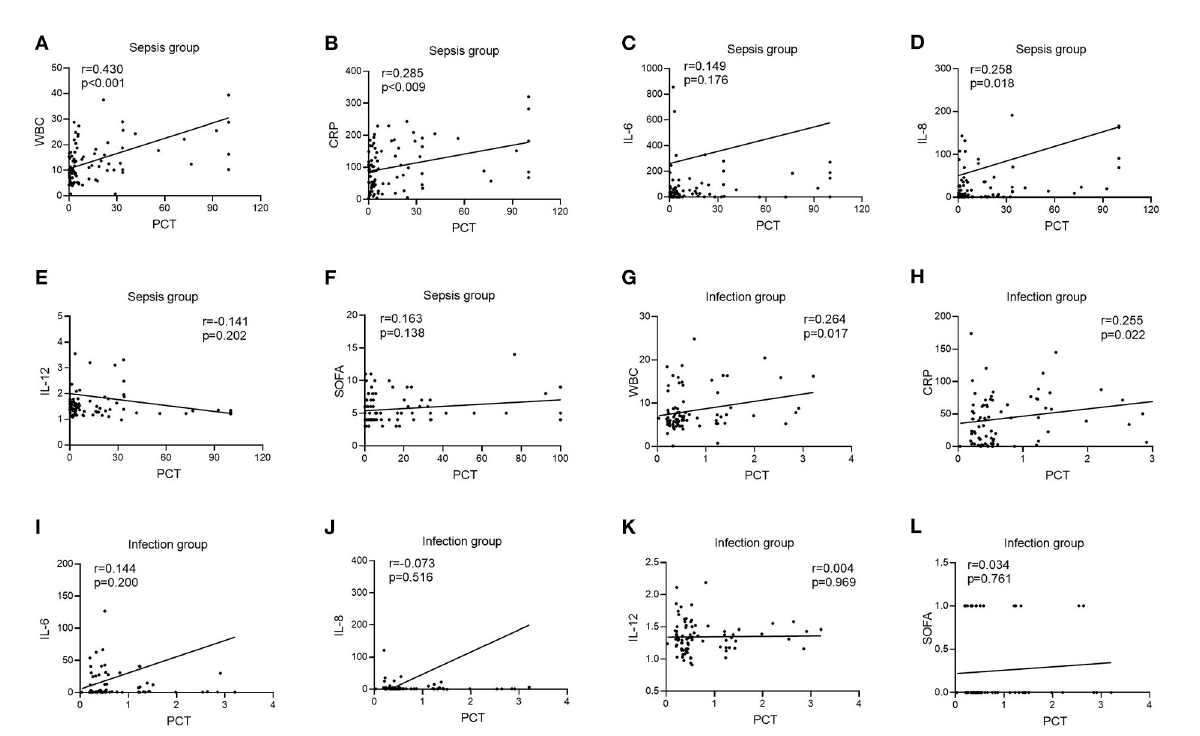
FIGURE5 Correlation of PCT with WBC, CRP, IL-6, IL-8, IL-12, and SOFA scores in patients in the infection and sepsis groups. (A) Correlation of PCT with WBC in patients in the sepsis groups; (B) Correlation of PCT with CRP in patients in the sepsis groups; (C) Correlation of PCT with IL-6 in patients in the sepsis groups; (D) Correlation of PCT with IL-8 in patients in the sepsis groups; (E) Correlation of PCT with IL-12 in patients in the sepsis groups; (F) Correlation of PCT with SOFA scores in patients in the sepsis groups; (G) Correlation of PCT with WBC in patients in the infection groups; (H) Correlation of PCT with CRP in patients in the infection groups; (I) Correlation of PCT with IL-6 in patients in the infection groups; (J) Correlation of PCT with IL-8 in patients in the infection groups; (K) Correlation of PCT with IL-12 in patients in the infection groups; (L) Correlation of PCT with SOFA scores in patients in the infection